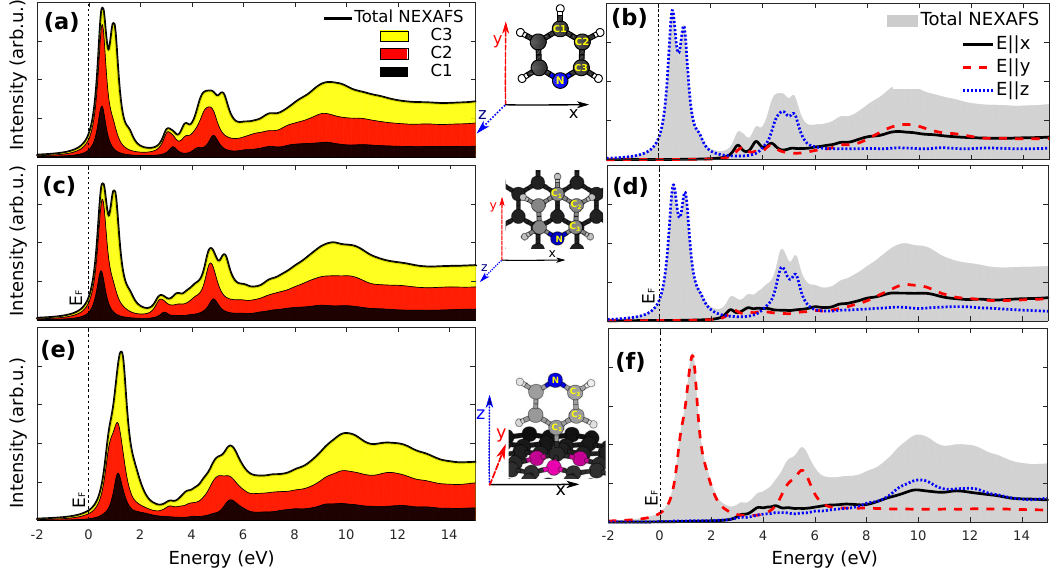
Figure 3. NEXAFS spectra at the C 1s edge for ( a ) the gas phase pyridine molecule showing the contribution of the inequivalent C atoms towards the final spectra and ( b ) the spectra for different electric polarizations are shown; ( c , d ) show corresponding data for the pyridine/graphene interface and ( e – f ) for the pyridine radical on graphene. The photon energy scale is aligned to the energy required to promote a C 1s electron to the graphene Fermi level. Panels ( a , b ), missing this reference, are aligned to match the pyridine/graphene